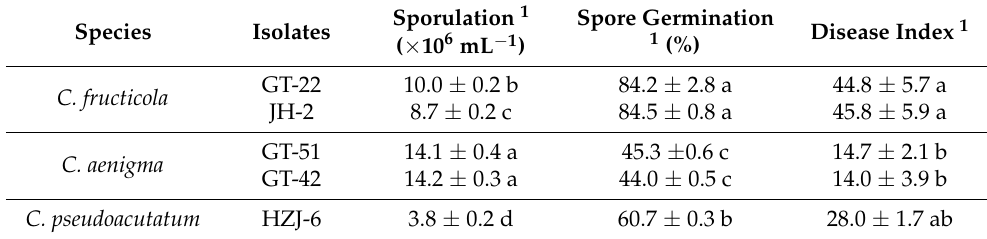
Table 2. Characterization of Colletotrichum species recovered from grapes.